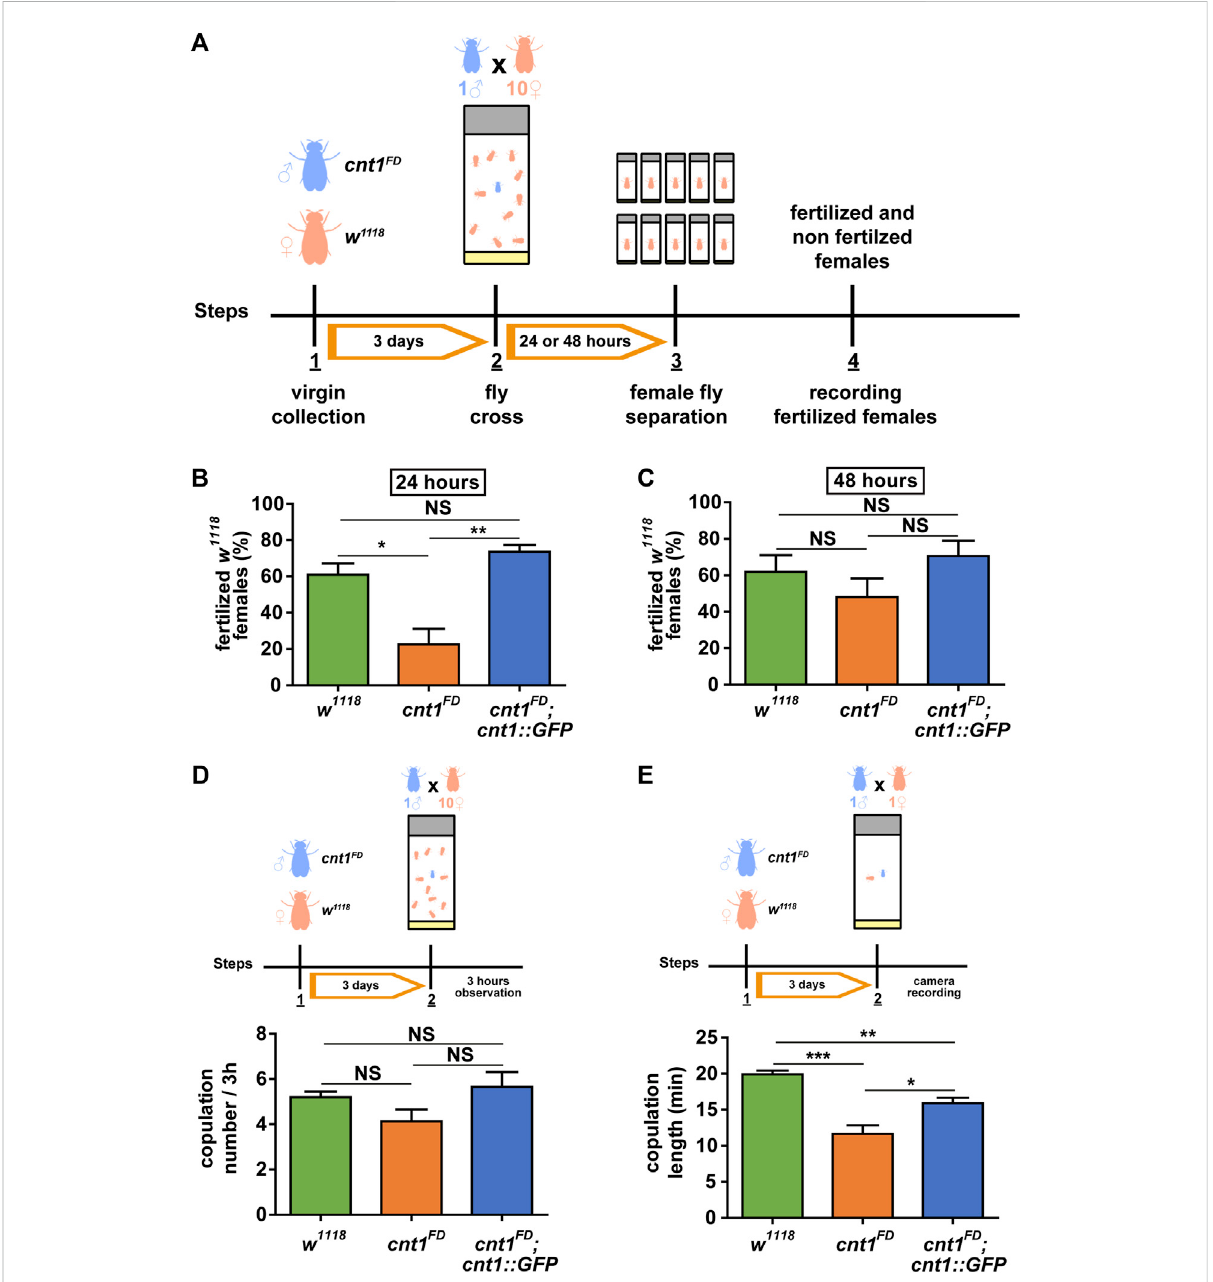
FIGURE 4 The cnt1 mutation causes partial sterility in Drosophila males. (A) Experimental procedure of the fertility assay. Virgin mutant males ( cnt1 FD ) and control females ( w 1118 ) were collected. After 3 days, one male was placed in a vial with 10 females for 24 or 48 h. Subsequently, each female was placed separately in a single vial, and the presence or absence of larvae was recorded. (B) Percentage of fertilized females after 24 h of mating with cnt1 FD males; n ≥ 10. (C) Percentage of fertilized females after 48 h of mating with cnt1 FD males; n ≥ 10. (D) Number of copulations within 3 h of observation.Virginmales( cnt1 FD )andfemales( w 1118 )werecollected.After3 days,onemalewasplacedinavialwith10females,andtheirmatingwas observed; n = 15. Error bars are presented as mean ± SEM. (E) Duration of copulation and experimental procedure. Virgin males ( cnt1 FD ) and females ( w 1118 ) were collected. After 3 days, a male was placed in a vial with a female, and mating was recorded with a camera. The calculated times of copulations are in minutes; n = 15. Signi fi cance was analyzed by one-way ANOVA (C) and Kruskal – Wallis (B,D,E) ; and labeled as follows: * p < 0.05, ** p < 0.01, *** p < 0.001, NS > 0.05. Error bars are presented as mean ±